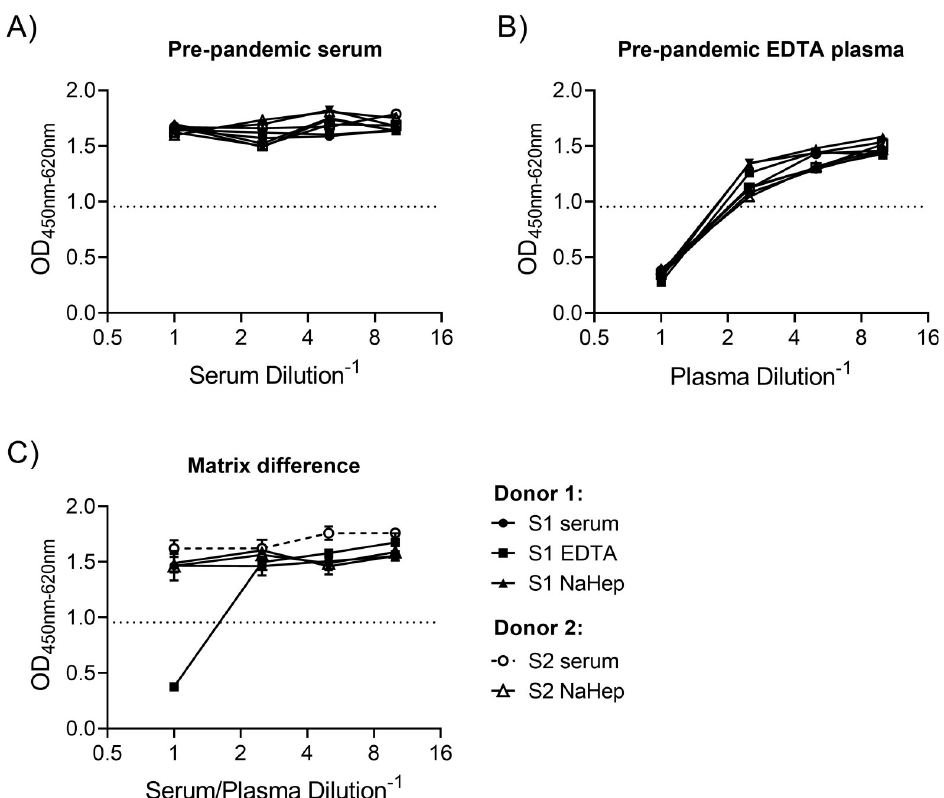
Fig 5. Sample matrix influence on specificity. (A) Neutralization activity on 8 negative pre-pandemic serum samples, and (B) 8 negative EDTA plasma samples run in duplicates and run undiluted, 1:2.5, 1:5 and 1:10. (C) Neutralization activity on serum, EDTA or sodium heparin (NaHep) samples collected from two donors on the same day tested in duplicate and run undiluted, 1:2.5, 1:5 and 1:10. Virus: early pandemic strain (lineage B.1). Error bars represent standard deviations of duplicate determinations. ELISA primary antibody: rabbit mAb